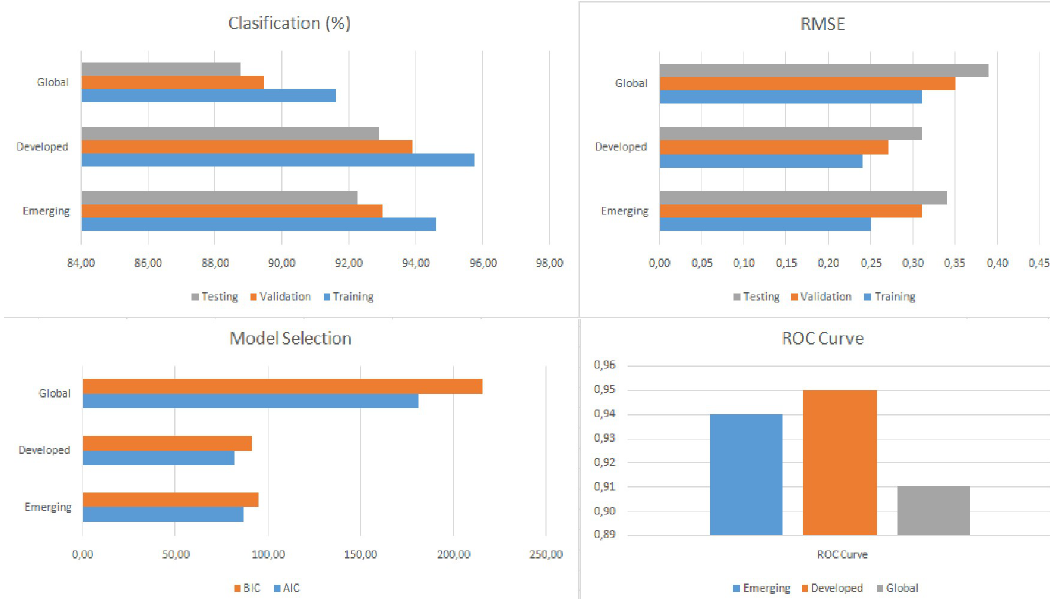
Fig 5. Results of accuracy evaluation for